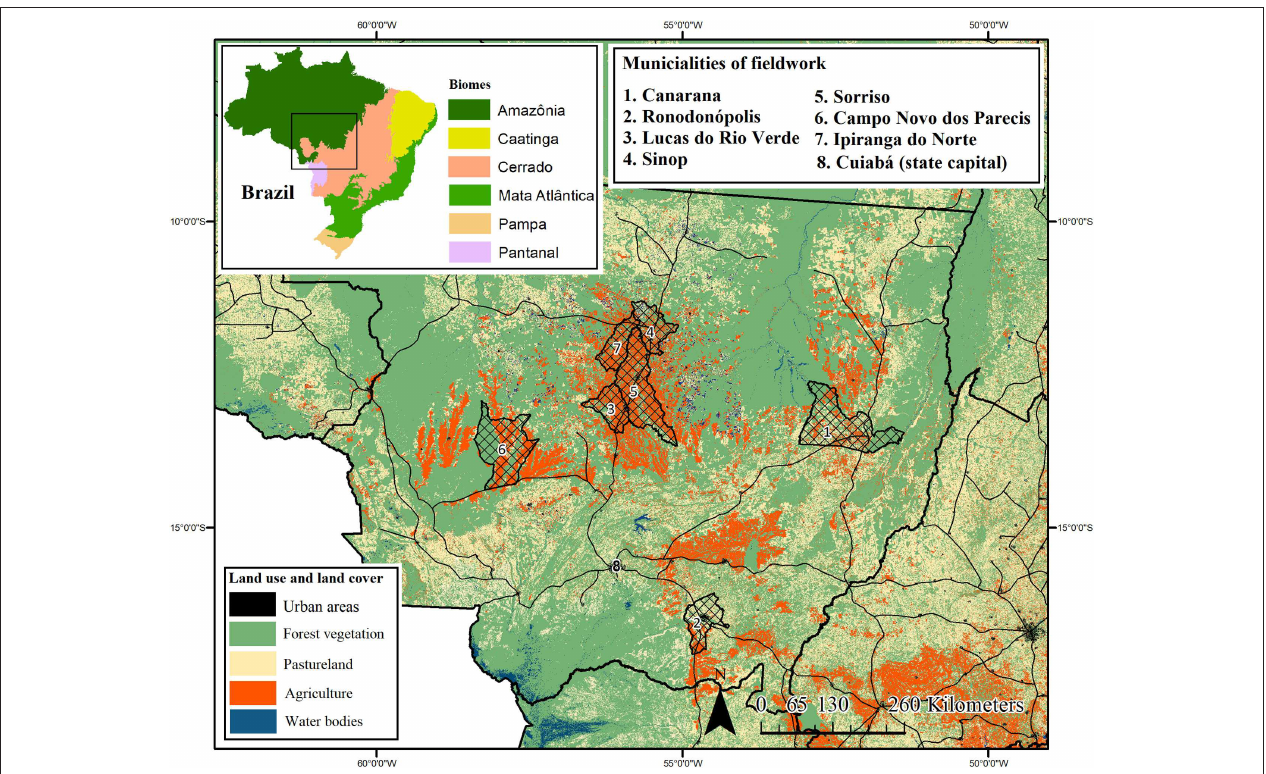
FIGURE 2 | Geographical distribution of the municipalities surveyed during the fieldwork of 2017, in Mato Grosso State, Brazil. Land use and land cover data source: Mapbiomas (http://mapbiomas.org/).